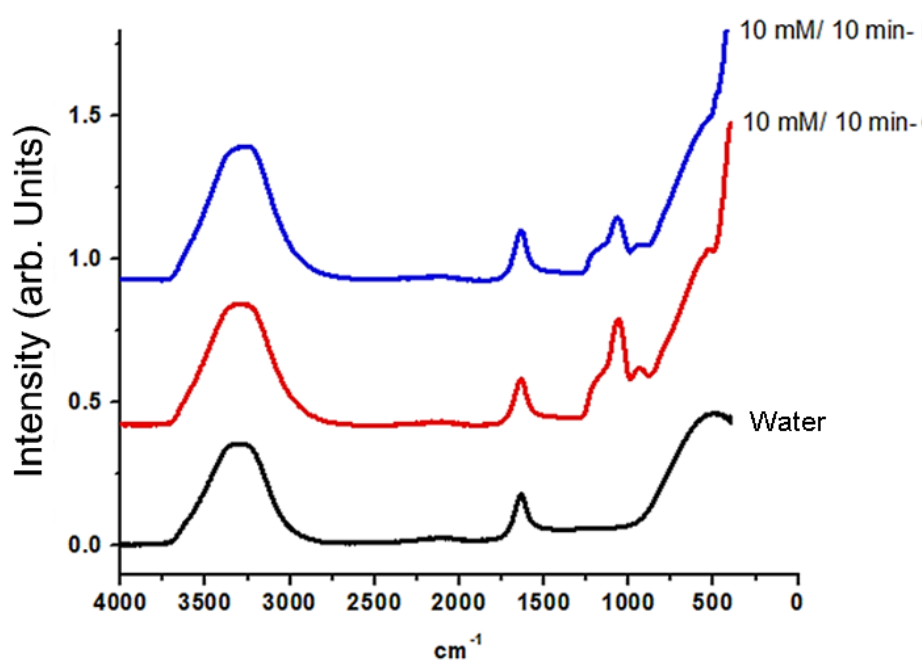
Figure 8. Infrared spectra of pyridine (1 nm) and crystal violet (CV) on the support doped for 10 min in a concentration of 10 mM AgNO 3 , and water.